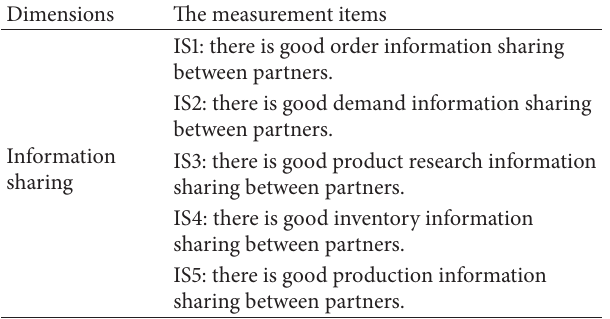
Table 7: The specific indexes of specificity of cooperative perfor-